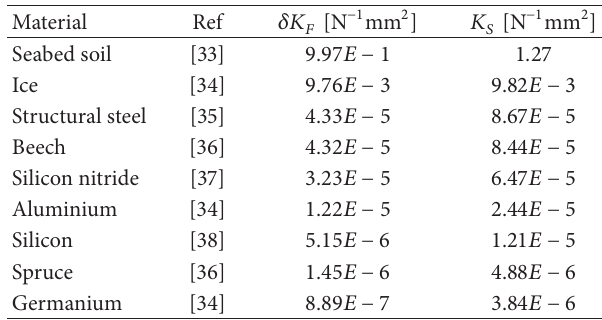
Table 1: Some materials involved in contact problems application.